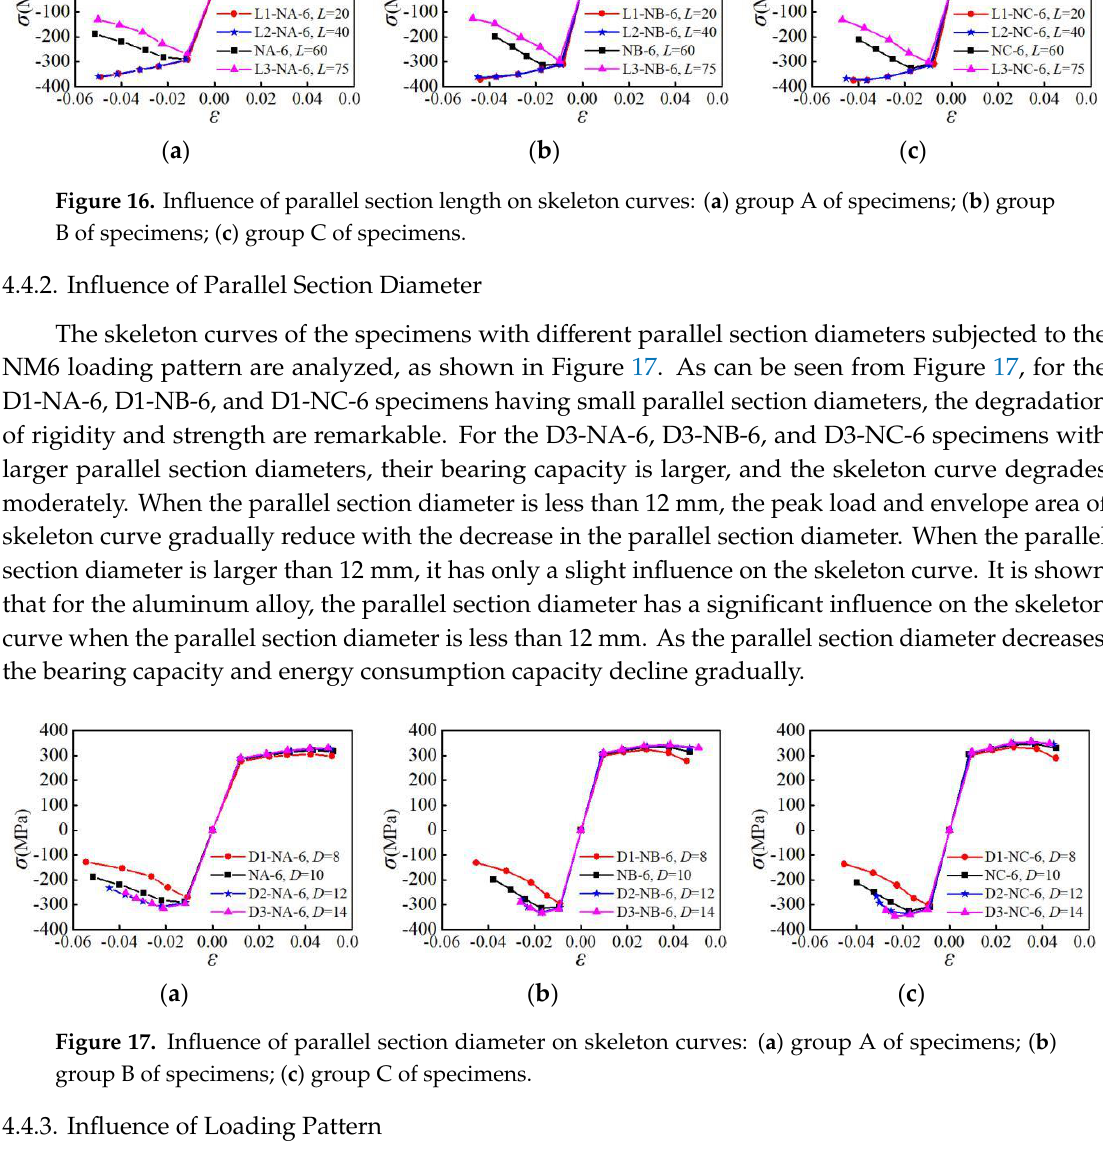
( c ) Figure 18. Influence of loading pattern on skeleton curves: ( a ) group A of specimens; ( b ) group B of specimens; ( c ) group C of specimens. 4.5. Stiffness Degradation In order to study the stiffness degradation law of aluminum alloys under low-cycle fatigue loading the secant stiffness is used to quantitatively analyze the stiffness degradation. The calculation formula of the secant stiffness K i is: